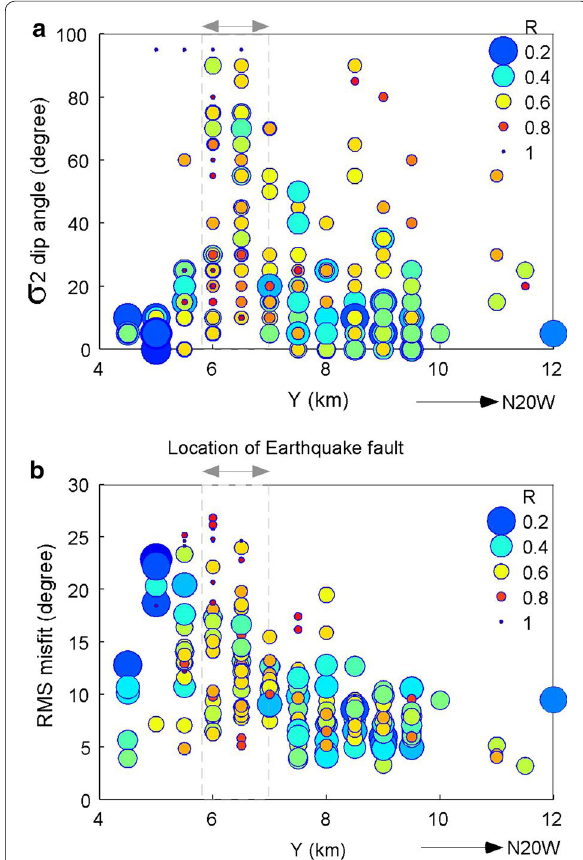
Fig. 8 Spatial changes in σ 2 dip angles ( a ) and root mean square (RMS) differences between observed and calculated slip directions (misfit) ( b ) in the direction perpendicular to the fault strike. Stress ratio R is indicated by the dimensions and colors of filled